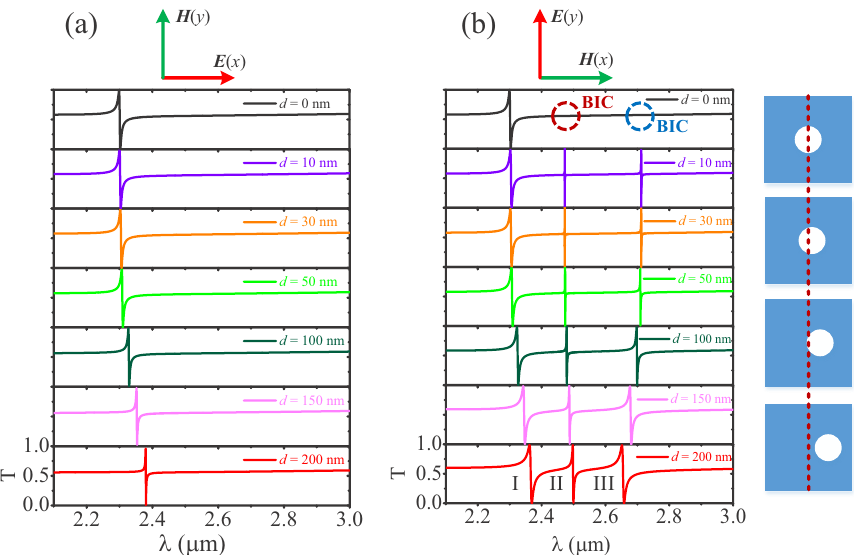
Figure 2. The transmission spectra under ( a ) x polarization and ( b ) y polarization with different asymmetric parameters d